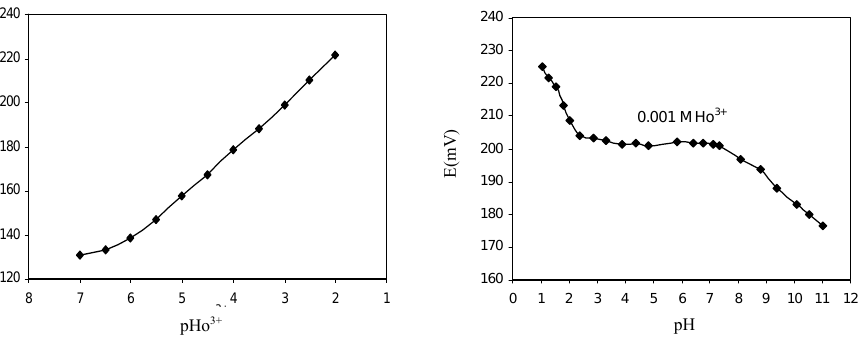
Figure 2. Calibration curve of holmium electrode based on QCA